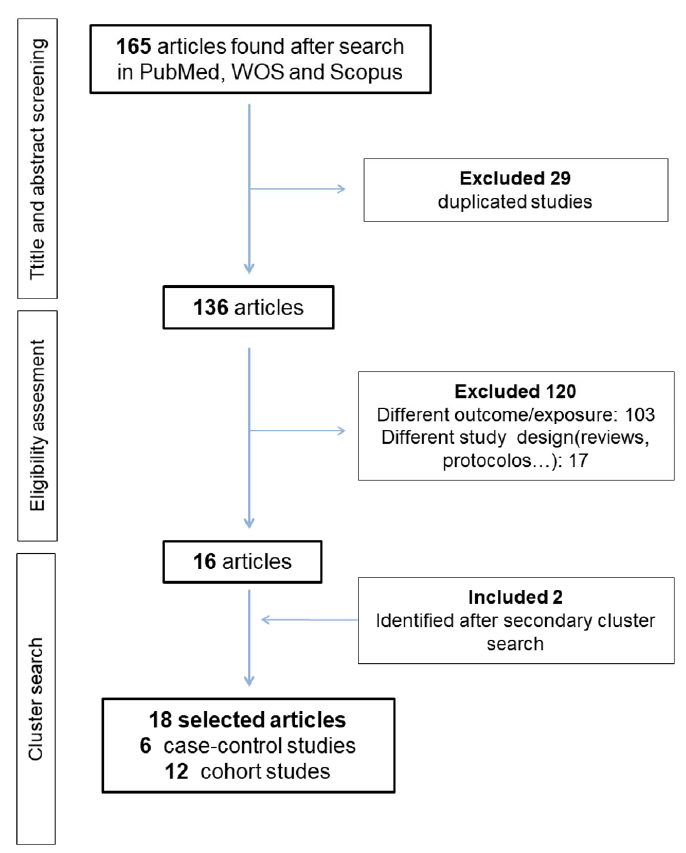
Figure 1. Flow diagram of article selection.